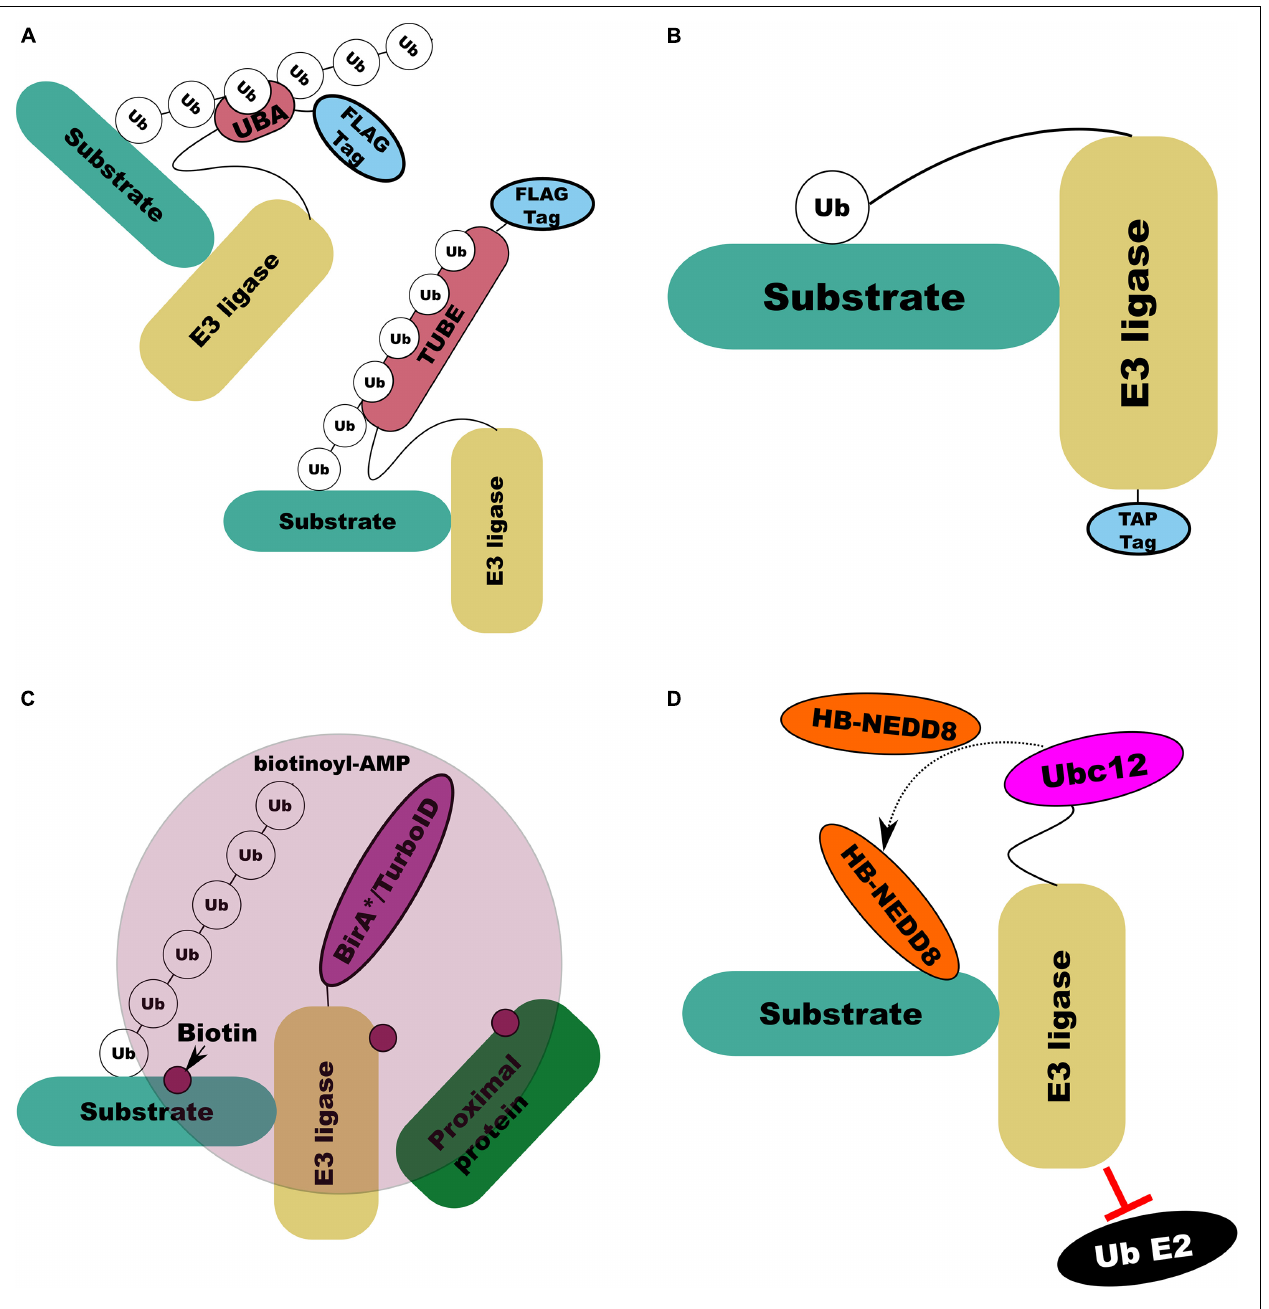
FIGURE 7 | Illustrations of E3 ligase substrate capture and labeling methods. (A) UBA (top left) and tandem UBA (TUBE; bottom right) capture by increasing the affinity of the E3 ligase modified with the UBA or TUBE domain for its ubiquitinated substrates. (B) UBAIT capture forming a covalent E3-substrate complex through C-terminal modification of the E3 itself with ubiquitin via a flexible linker. (C) BioID/TurboID based proximity labeling in which modified BirA enzyme conjugated to an E3 ligase of interest results in biotin labeling of interacting and associated proteins by creating a pool of reactive biotinoyl-AMP. (D) NEDDylator capture, in which an E3 ligase with E2 ubiquitin interaction domain disrupted to prevent substrate ubiquitination is fused to NEDD8 conjugating E2 (Ubc12). With co-expression of his-biotin (HB) tagged NEDD8 this enables HB-NEDD8 tagging of E3 ligase substrates.